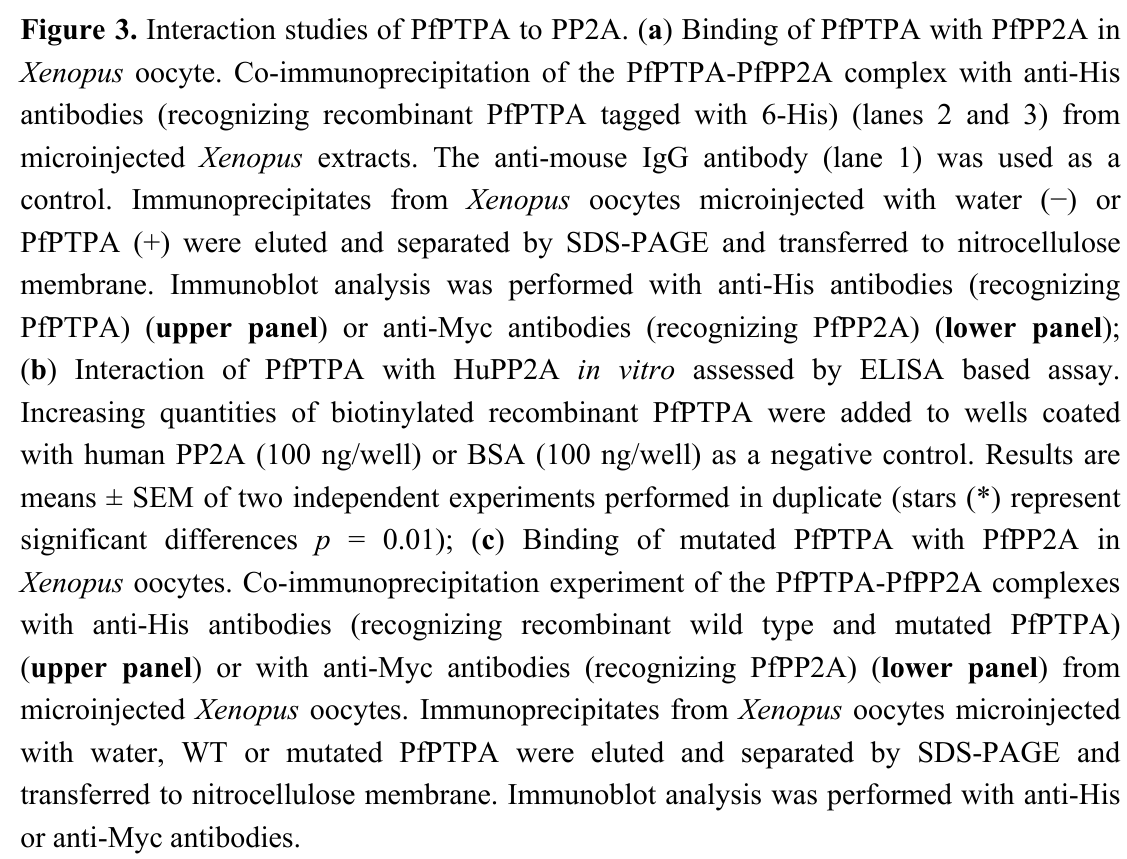
Figure 3. Interaction studies of PfPTPA to PP2A. ( a ) Binding of PfPTPA with PfPP2A in Xenopus oocyte. Co-immunoprecipitation of the PfPTPA-PfPP2A complex with